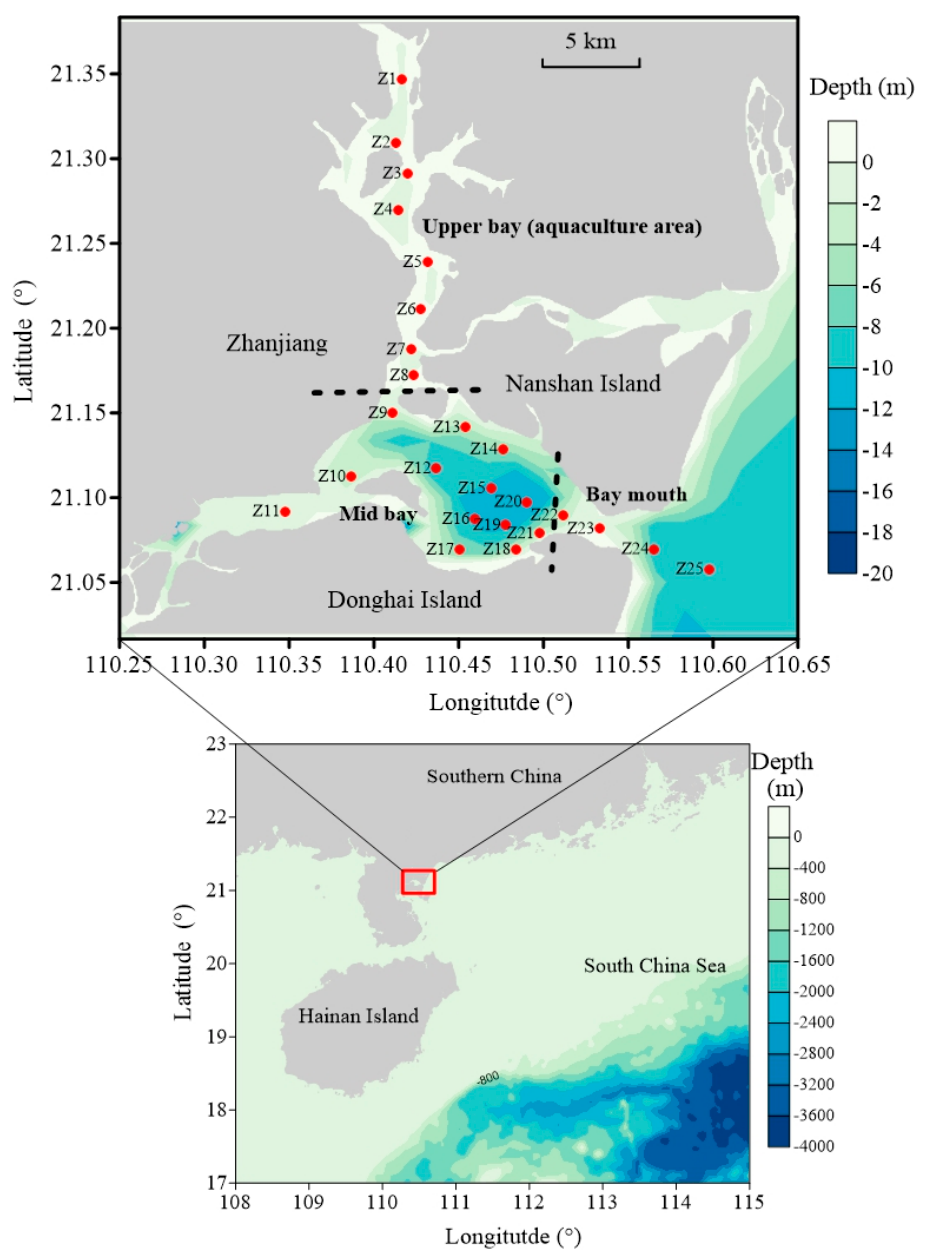
Figure 1. Map of Zhanjiang Bay showing the sampling stations. The red circle denotes the sampling station. The black dashed line indicates the boundary between the upper bay, mid-bay, and bay mouth segments. The upper bay is mainly used for aquaculture activities and the mid-bay is mainly used for shipping.